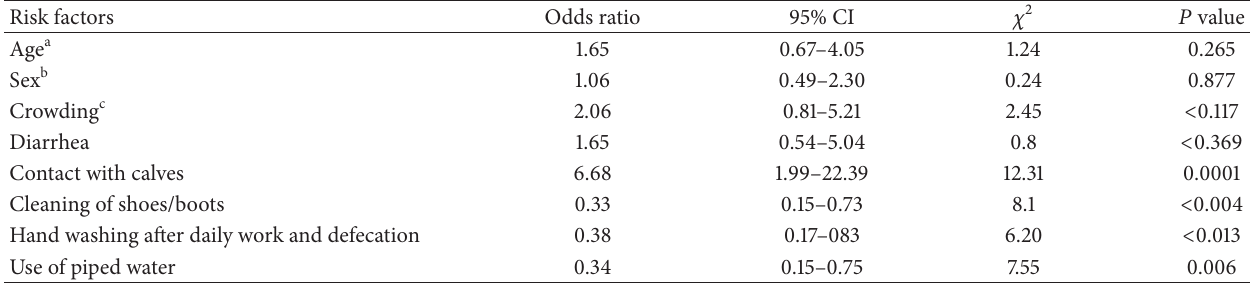
Table 5: Univariate analysis of association between potential risk factors and Cryptosporidium parvum infection in farm workers and their household members.